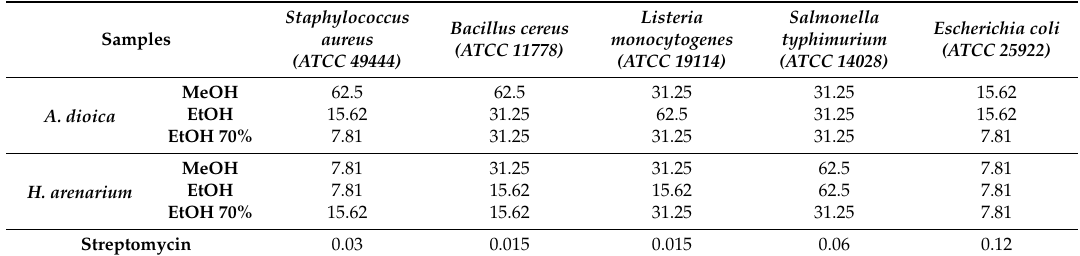
Table 6. Minimum inhibitory concentration—MIC (mg/mL) of H. arenarium and A. dioica extracts and standard antibiotic.